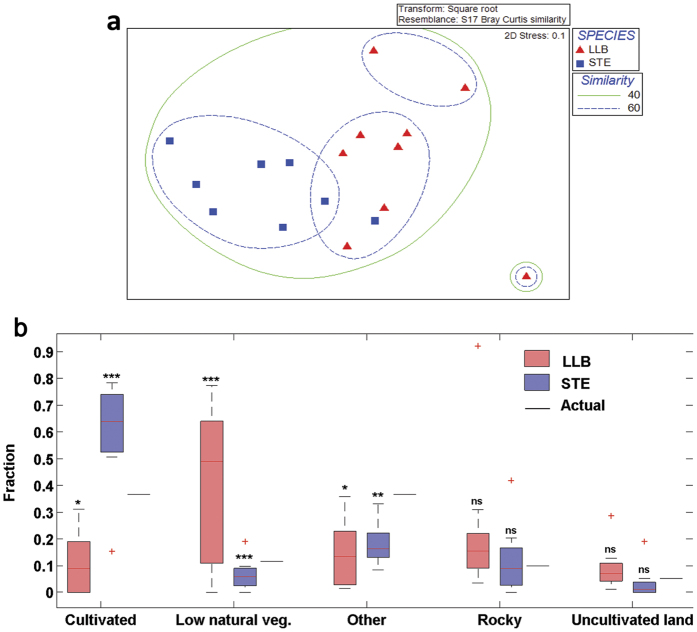
(a) Multi-dimensional scaling (MDS) plot of similarity in habitat type used for foraging by the two raptor species during the breeding season. Each point represents one individual. The habitat types of LLB and STE were significantly different from each other. The lines represent 40% and 60% similarity contours, so all samples inside each contour have a similarity above these two values, (b) Box plot of habitat type used by each species in comparison (one sample t–test) to habitat type availability in the whole study area (“Actual” line). Box = 25th and 75th fractions; bars = min and max values; red lines = median; red dots = outliers. Note that each species foraged in different habitat types; LLB showed a clear significant preference to low natural vegetation, and significantly avoided cultivated fields, while STE showed an opposite behavior by significant preference of cultivated fields and significant avoidance of low natural vegetation. *= 0.01 < P < 0.05, **= 0.001 < P < 0.01, ***= P < 0.001, ns = not significant (P > 0.05).